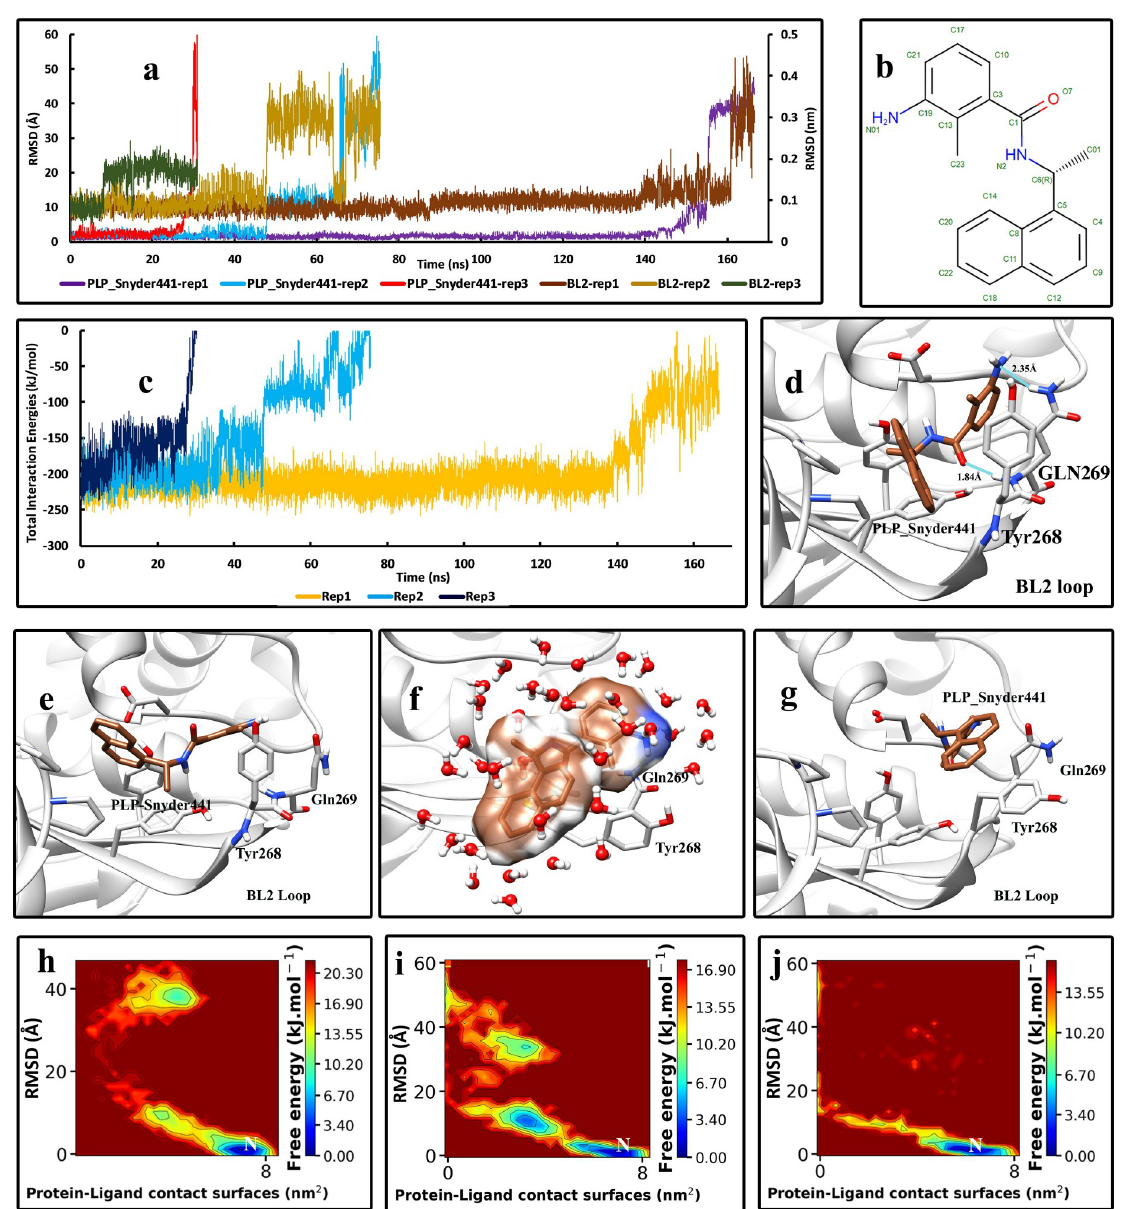
Fig 3. The details of the unbinding pathway of PLP_Snyder441 from SARS-CoV-2 Plpro in three series of replicas. (A) The RMSD values of the inhibitor in three replicas (Displayed in Å ) and the backbone RMSD values of residues of the BL2 loop in three replicas (Displayed in nm) throughout the simulations. (B) The 2D structure of PLP_Snyder441 was obtained from PDB. (C) The Total interaction Energies of the protein-ligand complexes throughout the simulations. (D) The bound state of the PLP_Snyder441 in the crystallographic (native) conformation and the interactions with the residues of the binding pocket (frame at 0 ns). (E) An intermediate state of PLP_Snyder441 in the unbinding pathway where the BL2 loop gradually starts to take some distance from the enzyme (1 st replica, frame in 150 ns). (F) Another intermediate state where the BL2 loop is entirely flat and the inhibitor is stuck to the residues on the tip of the loop (Tyr268 and the Gln269) and is almost solvated (2 nd replica, frame in 55 ns). (G) The unbound state of the inhibitor is entirely free and solvated in the simulation box. (H) The free energy landscape (FEL) representation of the unbinding pathway of the PLP_Snyder441, replica No 1. (I) The free energy landscape (FEL) representation of the unbinding pathway of the PLP_Snyder441, replica No 2. (J) The free energy landscape (FEL) representation of the unbinding pathway of the PLP_Snyder441, replica No 3. Letter “N” indicates the native crystallographic conformation.